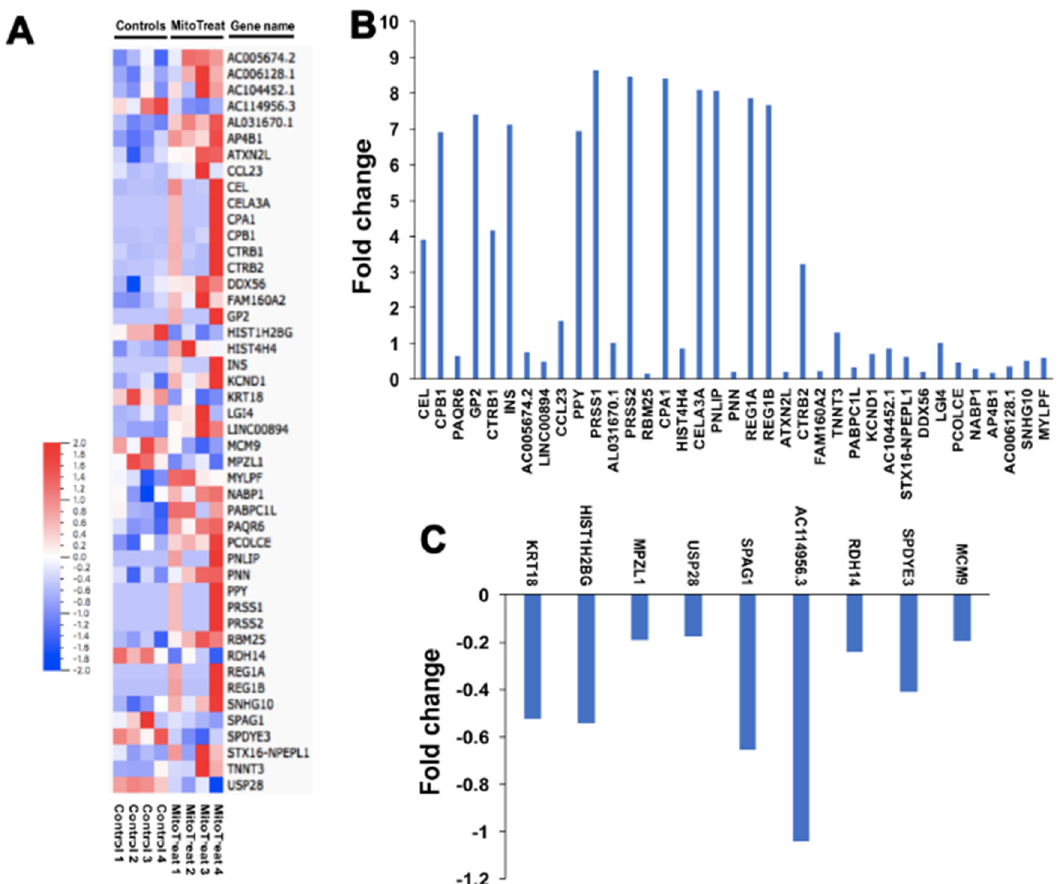
Figure 6. RNA-seq analysis in PB-IPC. Differentially expressed genes shown by the RNA-seq in four PB-IPC preparations treated with mitochondria. Untreated PB-IPC served as controls. ( A ) The heatmap revealed that forty-six most differentially expressed genes in PB-IPC post the treatment with mitochondria. ( B ) Thirty-seven up-regulated genes in PB-IPC post the treatment with mitochondria. ( C ) Nine down-regulated genes in PB-IPC post the treatment with mitochondria. To circumvent the limitation of adult stem cells, functional tissue cells (e.g., insulin-producing cells or islet cells) have been generated from embryonic stem (ES) cells and induced pluripotent stem cells (iPS) through ex vivo induction of di ff erentiations [20,40–42]. However, recent advance in